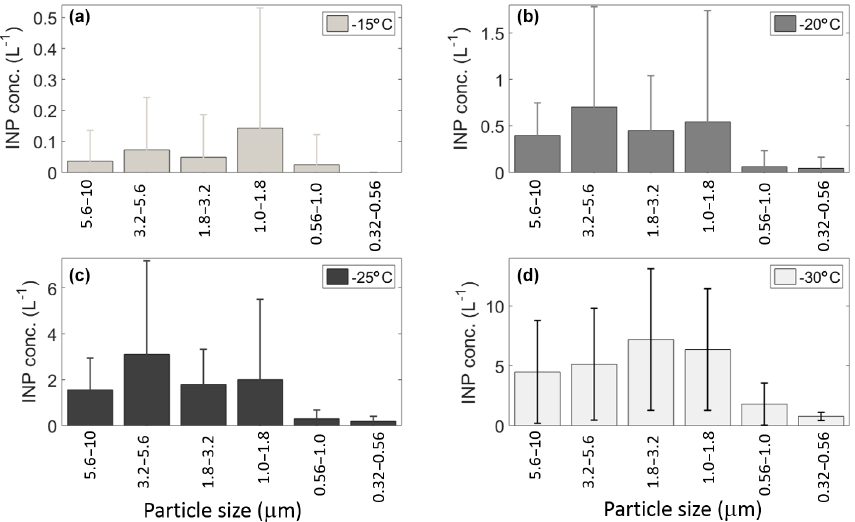
Figure 6. Mean INP concentration as a function of aerosol particle size at (a) − 15, (b) − 20, (c) − 25, and (d) − 30 ◦ C. Uncertainties are given as the standard uncertainty of the